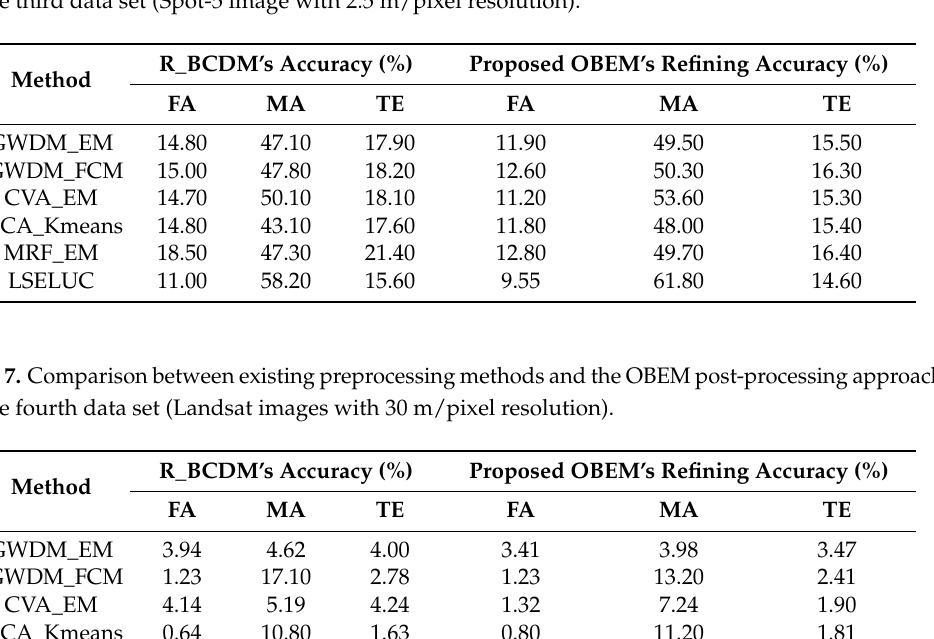
Table 6. Comparison between existing preprocessing methods and the OBEM post-processing approach for the third data set (Spot-5 image with 2.5 m/pixel resolution).